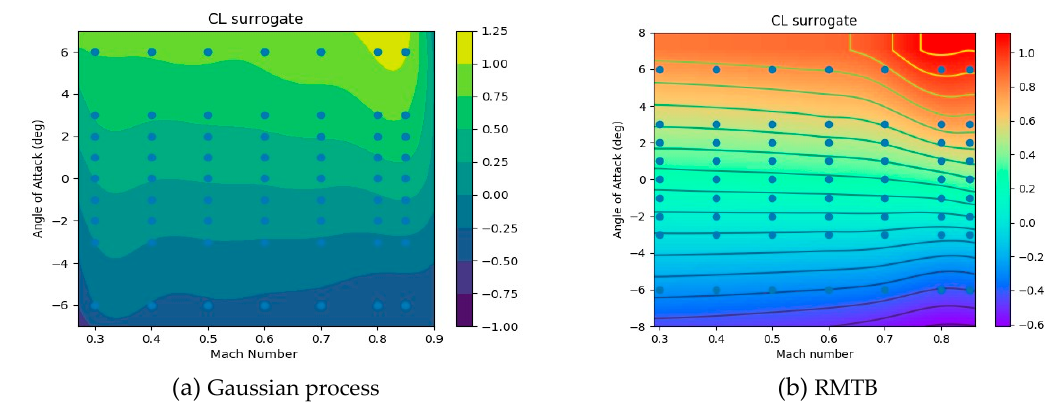
Figure 7. Comparison between the RMTB and Gaussian process surrogates for the compressibility drag coefficient.